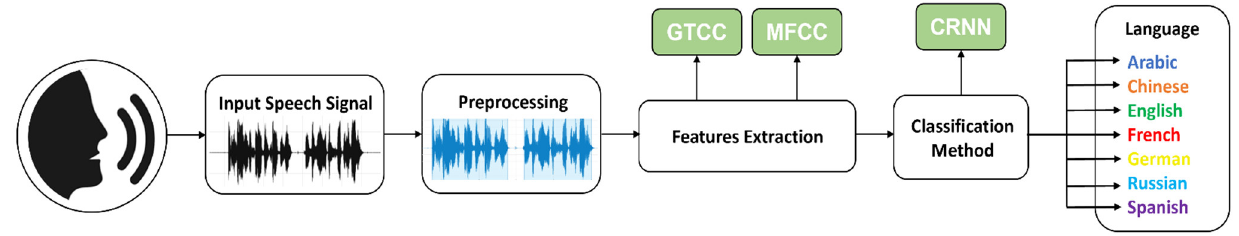
Figure 1. Spoken LID